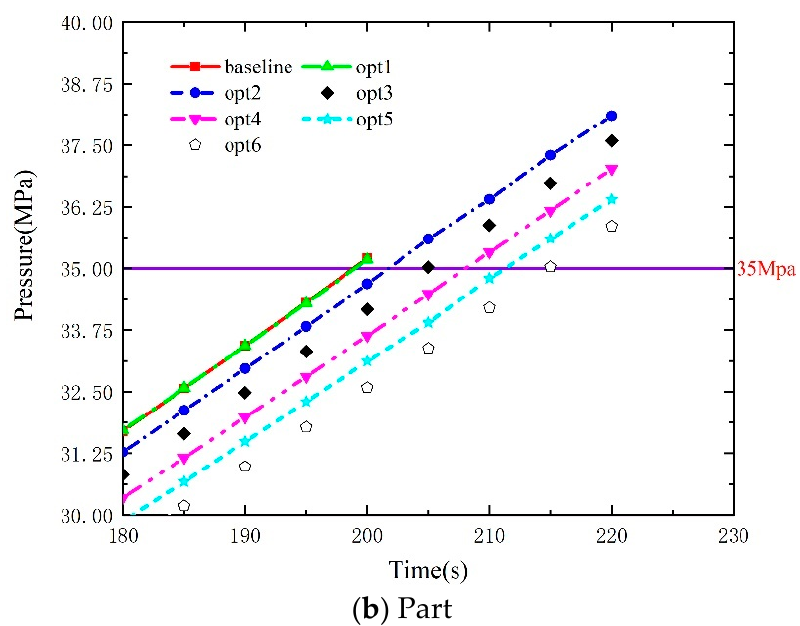
Figure 6. Average pressure inside cylinders for benchmark and precooling schemes.